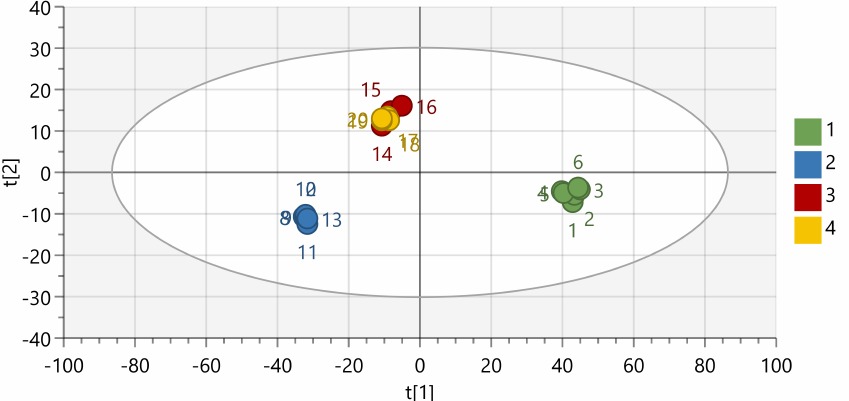
Figure 6. PCA of the full Raman spectra for PEO (class 1, green), Kollidon VA64 (class 2, blue), and KVA64:PEO (70:30, 140°C) filaments near fissures (class 3, red) and smooth parts of the same KVA64:PEO filament (class 4,